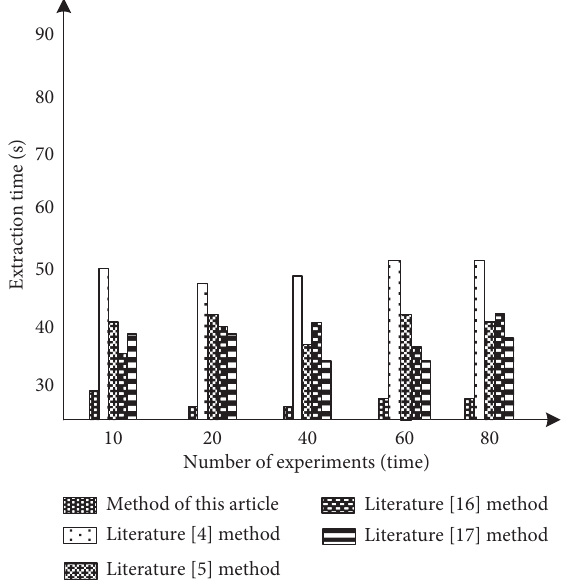
Figure 8: Comparison results of sports image posture contour extraction